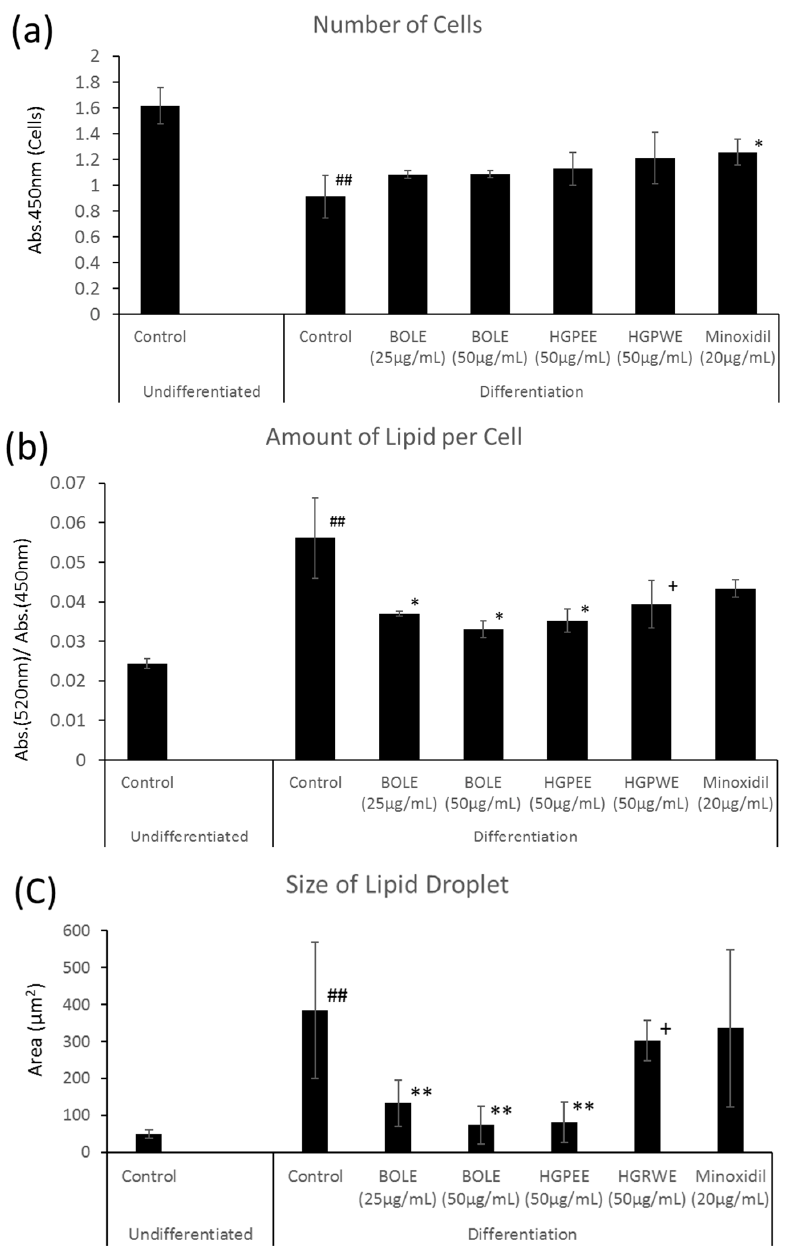
Figure 1. Effects of Biota orientalis L. leaf extract (BOLE), hair growth plant ethanol extract (HGPEE), and minoxidil on the number of hamster sebocytes ( a ); amount of lipids per cell ( b ); and size of lipid droplets ( c ). n = 3, mean ± S.D. ## p < 0.01 vs. Control (Undifferentiated); * p < 0.05 vs. Control (Differentiation); ** p < 0.01 vs. Control (Differentiation); + p < 0.1 vs. Control (Differentiation).